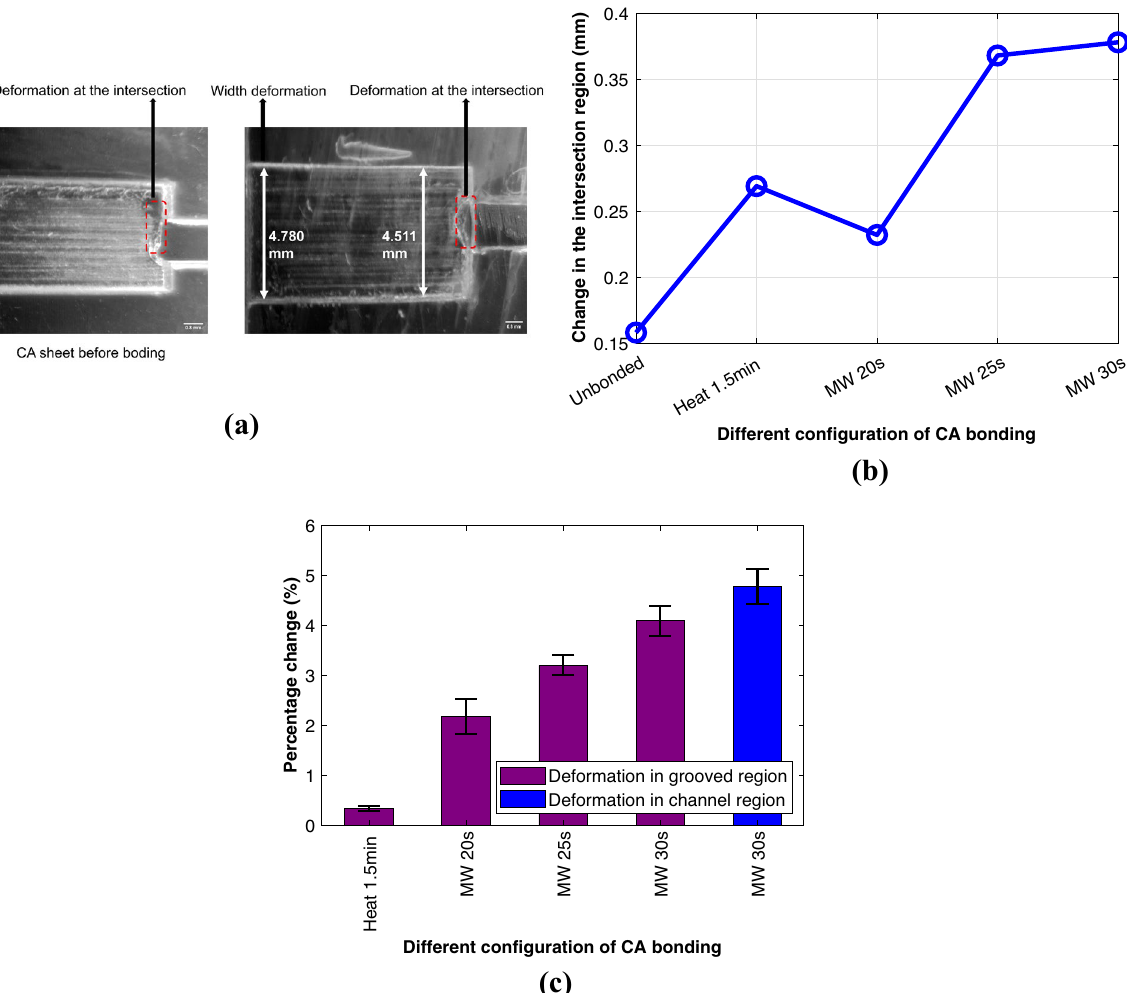
Figure 4. ( a ) (Left) Microscopic photographs of laser cut CA sheets before bonding. The CA sheet has a slight deformation at the intersection of grooved and channel cut region. (Right) Post bonding CA sheet for 30 s microwave bonding. ( b ) Change in the intersection region in mm for different configurations of CA bonding. ( c ) Percentage change in the grooved and channel cut region for different configurations of CA bonding. The ‘MW’ represents microwave induced and ‘Heat’ represents heat press based bonding. Minute is represented by “min” and second by